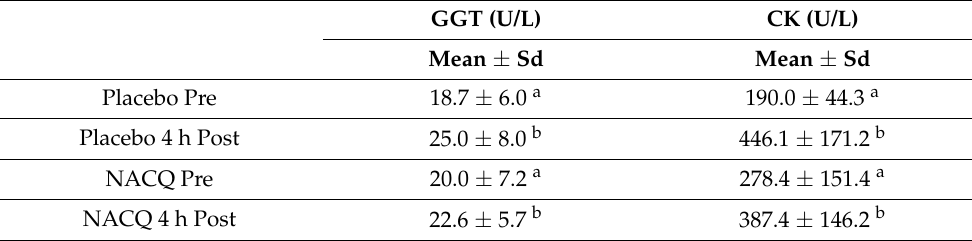
Table 2. Plasma gamma-glutamyl transferase (GGT) and creatine kinase (CK) activity in NACQ- and placebo-supplemented horses. Differences in superscripts a and b indicate significant differences with supplementation or exercise. There were no significant effects of NACQ/placebo supplementation, however there was a significant effect of exercise on GGT ( p = 0.008 and CK activities ( p < 0.001).